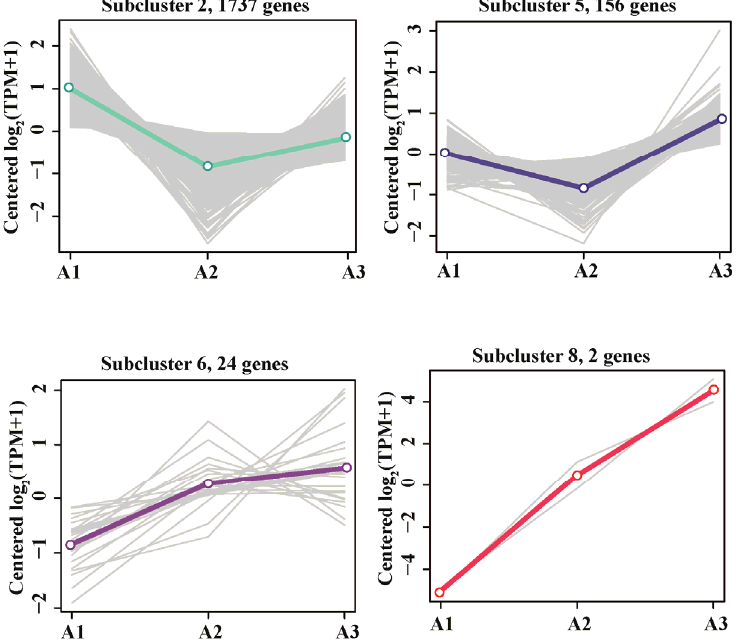
Figure 6. Trends in the expression patterns of upregulated DEG clusters at different concentrations of BPA.